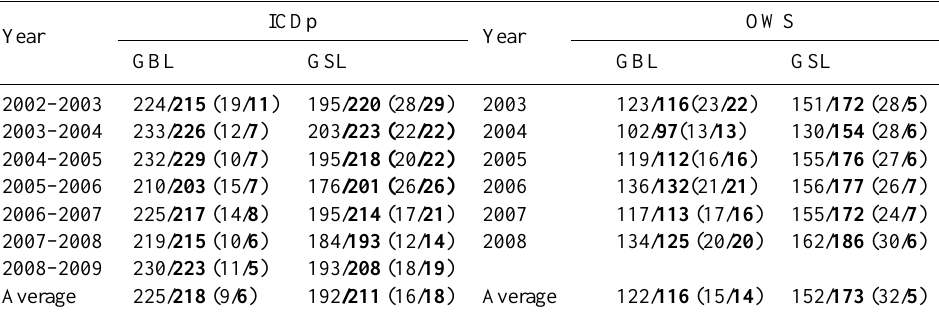
Table 5. Summary of ice cover duration (ICDp) and open water season (OWS) (average number of days) for GBL and GSL (2002–2009). Values within confidence regions in bold. Standard deviation in parentheses. Note that OWS was not calculated for 2009 since it requires ice-on date to be known for fall freeze-up period 2009, which was not determined in this